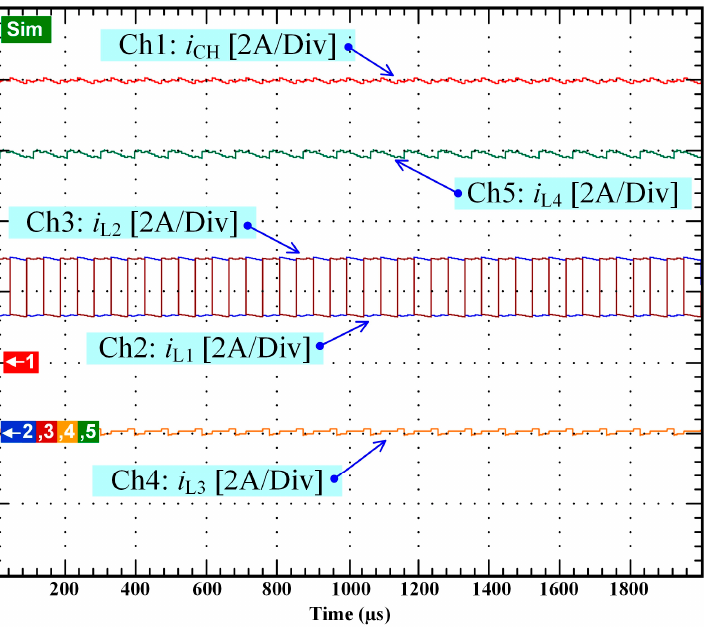
Figure 8. Simulation results: TLIBC performance with compensation technique only.